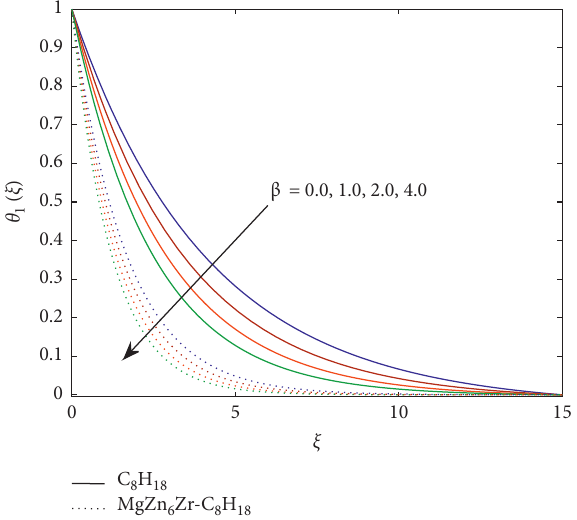
Figure 5: Temperature field in the flow of MgZn C H via β . 8 18